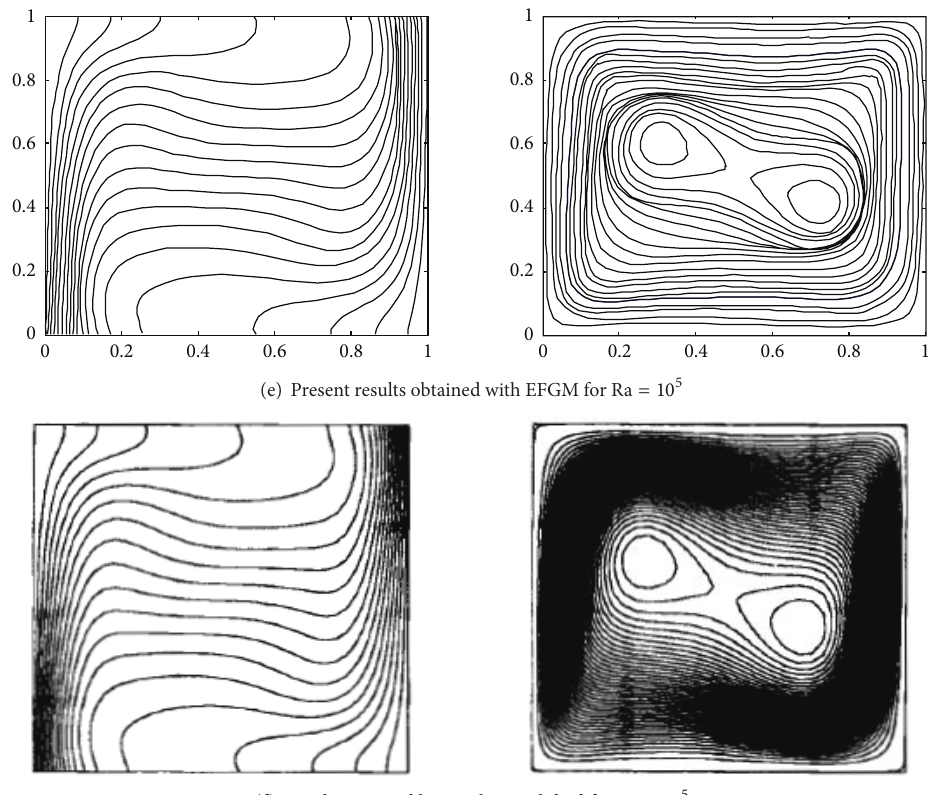
Figure 3: Comparison of streamlines and isotherms profile with benchmark results reported by Barakos et al. [22].